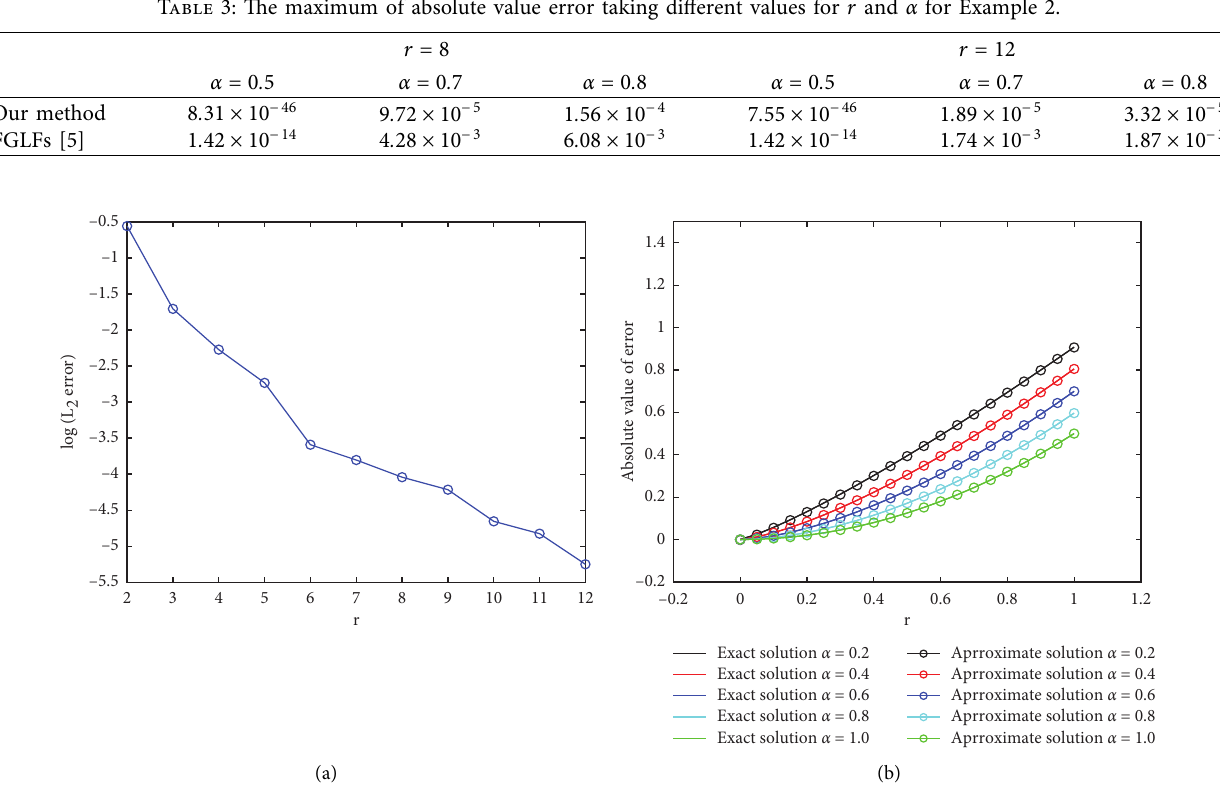
for Example 1. 1